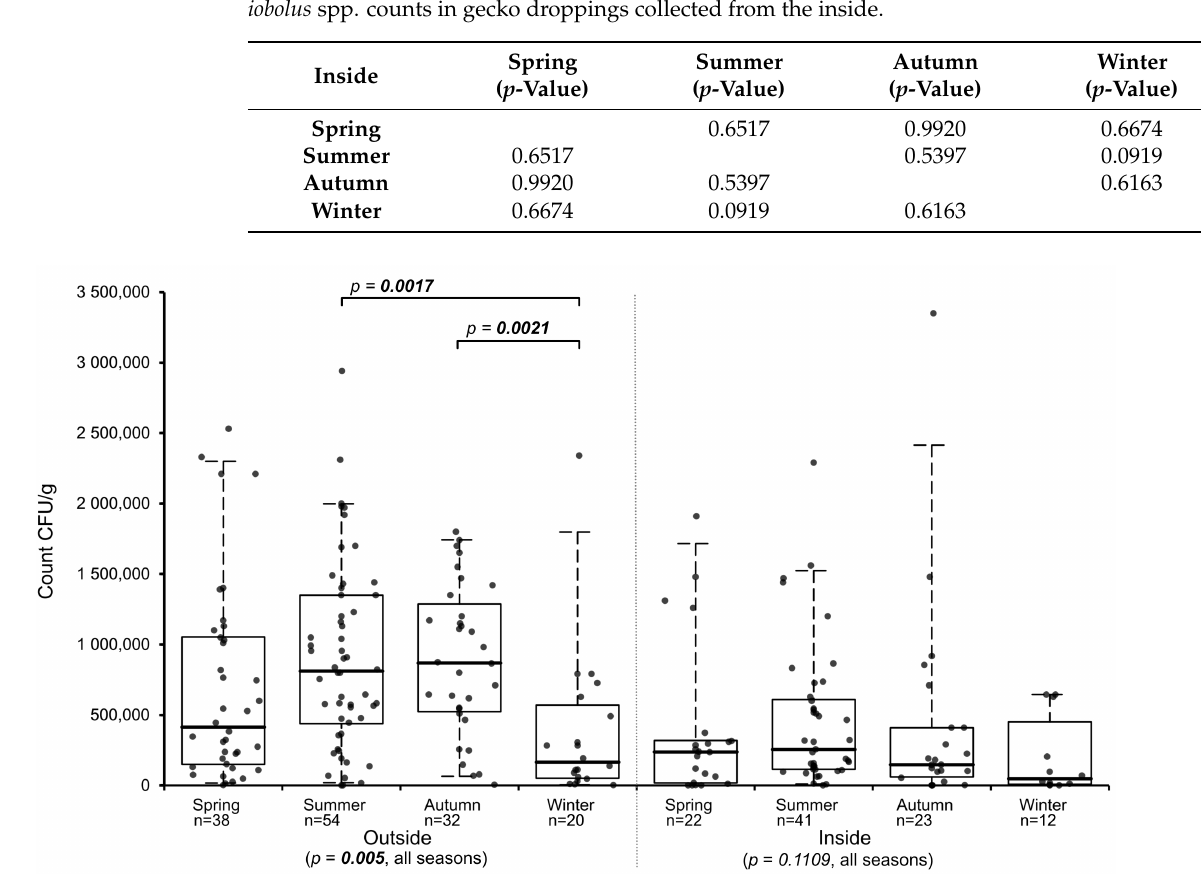
Figure 2. Seasonal comparison of viable Basidiobolus spp. counts established for inside (left hand) and outside gecko droppings (right hand). p -values below compare counts of all seasons per location using the Kruskal—Wallis test. p -values above show only significant values obtained using the post hoc test (Steel—Dwass—Critchlow—Fligner) comparing all seasonal pairs per location. Statistically significant differences are marked in